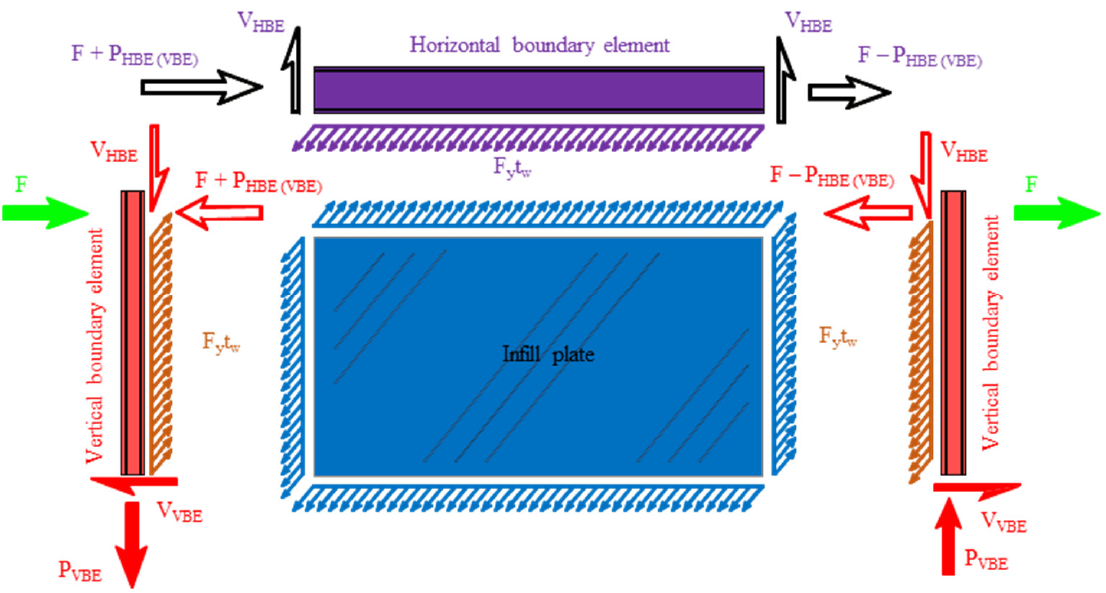
Figure 2. Load distribution in a typical SPSW system.